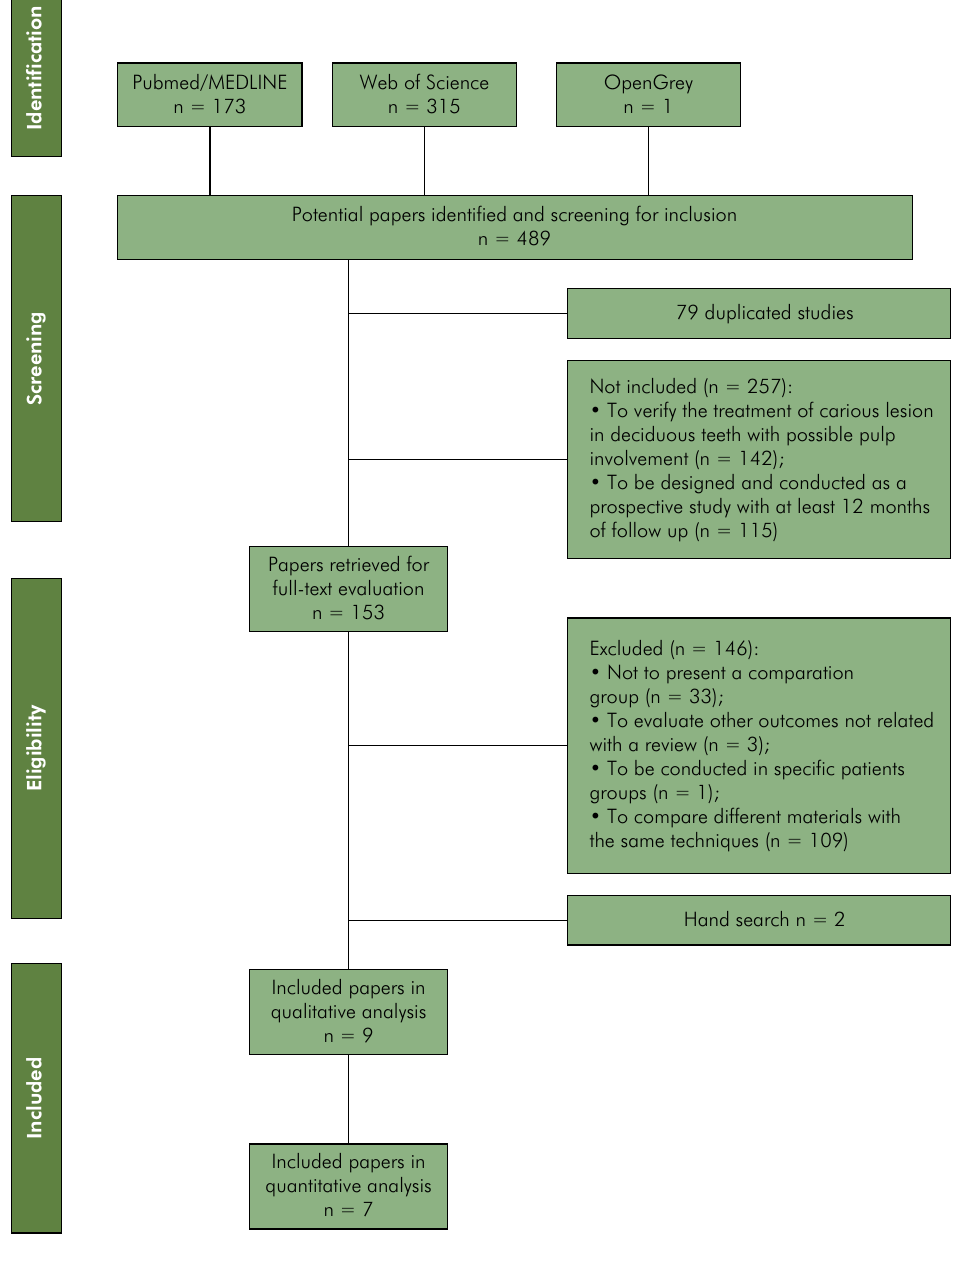
Figure 1. Flowchart of screening, eligibility, and analysis of